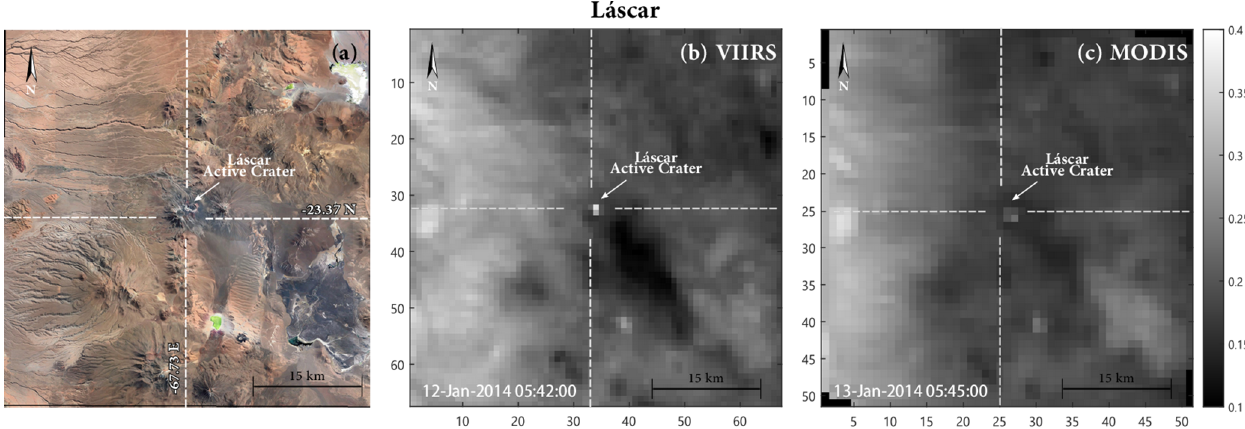
Figure 2. ( a ) Location of Láscar volcano (credits: Google Earth ® ); ( b,c ) examples of VIIRS ( b ) and MODIS ( c ) images acquired over Láscar. The images represent middle infrared (MIR) radiance data (band M13 and band 21/22, for VIIRS and MODIS, respectively) resampled and centered on the volcano summit at the original resolution of 750 m (for VIIRS) and 1000 m (for MODIS). Note how the different resolution allows a better definition of thermal anomalies. The bright pixels identify the thermal anomaly detected by the two sensors and related to the hot volcanic features present at the time of the image acquisitions.